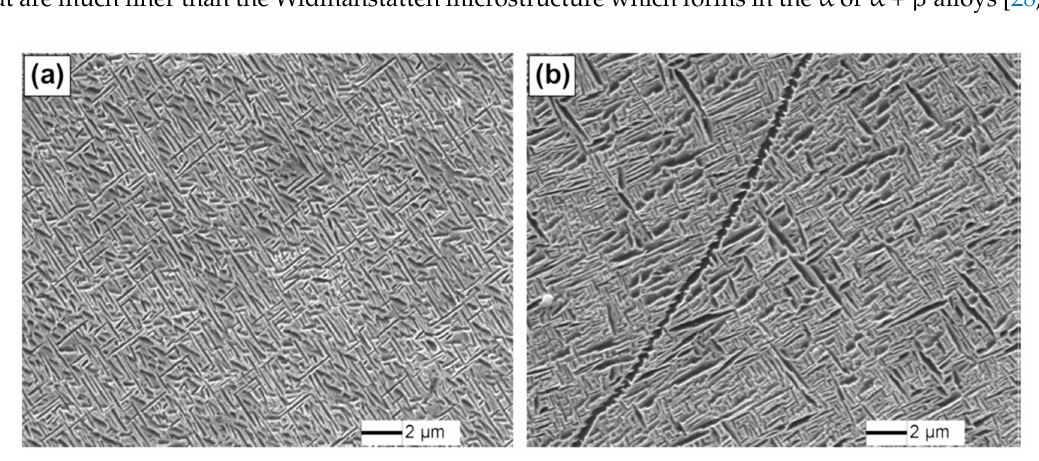
Figure 3. Scanning electron microscopy micrographs showing the typical microstructures of laser melting deposited Ti-5Al-5Mo-5V-1Cr-1Fe alloy: ( a ) between the layer bands and ( b ) within the layer bands (reproduced with permission from [28] Copyright Elsevier,